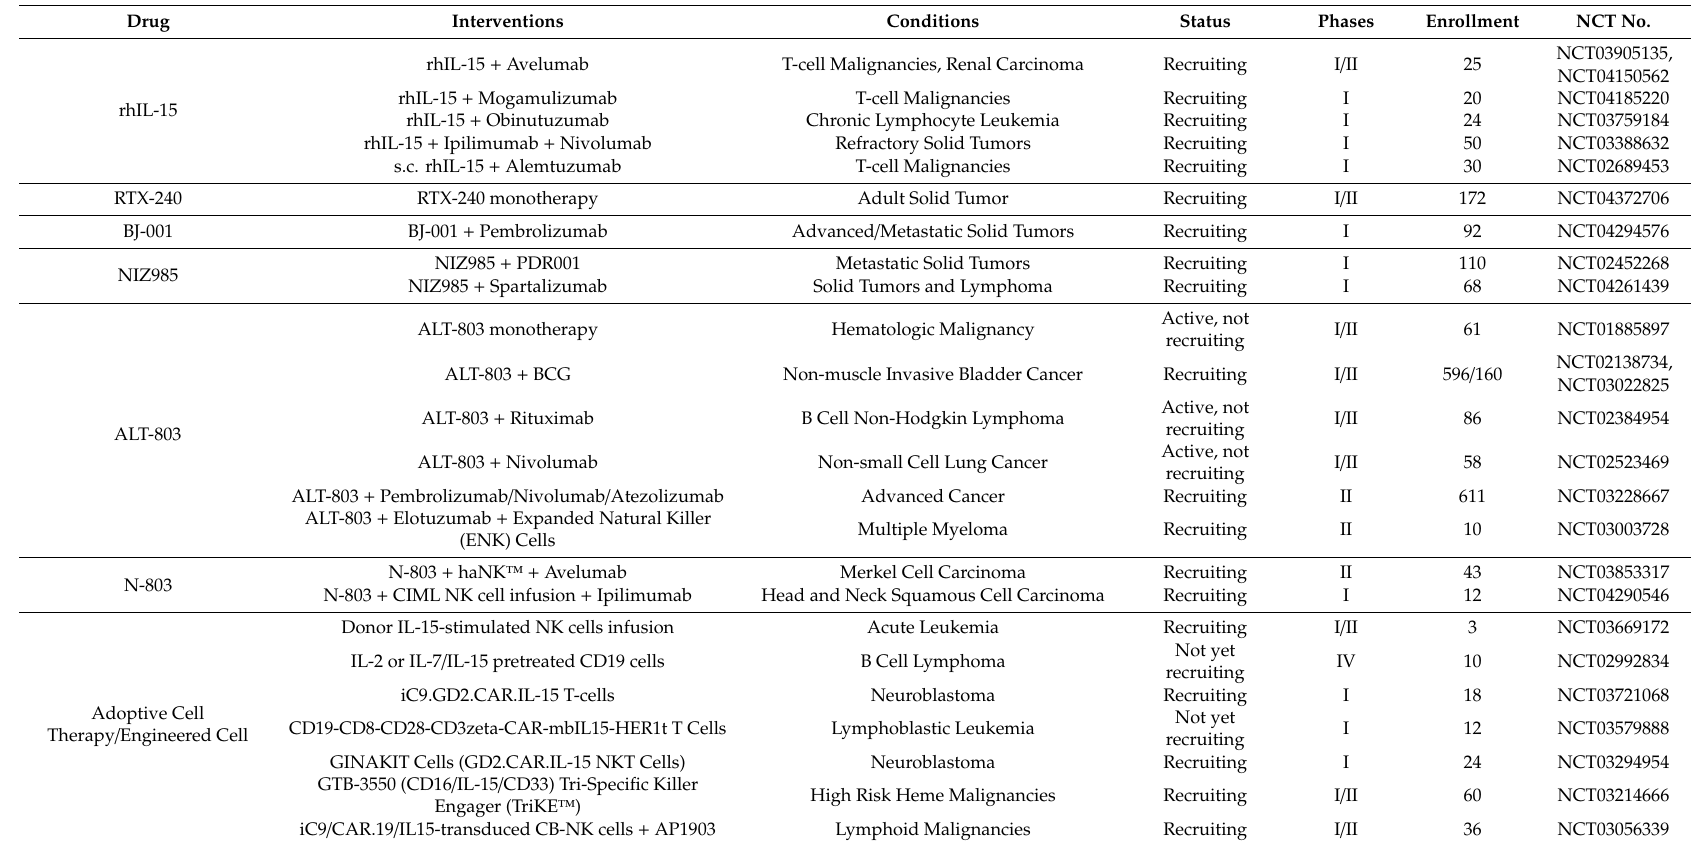
Table 2. Examples of ongoing clinical trials with